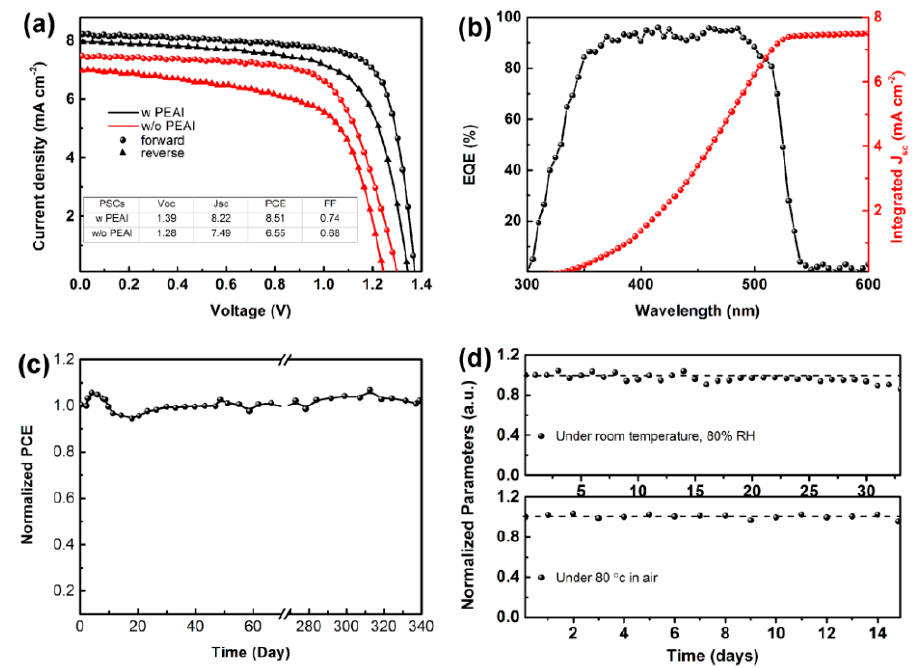
Figure 6. Characteristic J–V curves of PSCs based on CsPbBr 3 films without and with PEAI doping at 10 mg/mL, and ( a ) the inset shows corresponding photovoltaic parameters; ( b ) PCE spectrum of the champion device; ( c ) storage stability in the ambient air without encapsulation; ( d ) stability under harsh conditions.